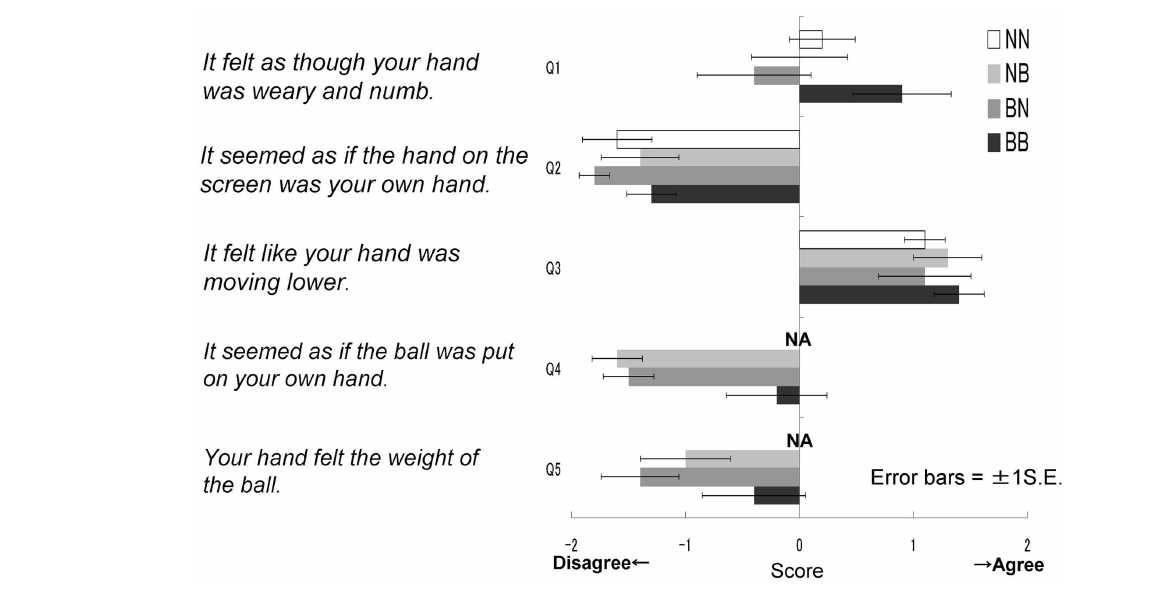
FIGURE 4 | Questionnaire scores in each group in Experiment IA. It felt as though your hand was weary and numb. It seemed as if the hand on the